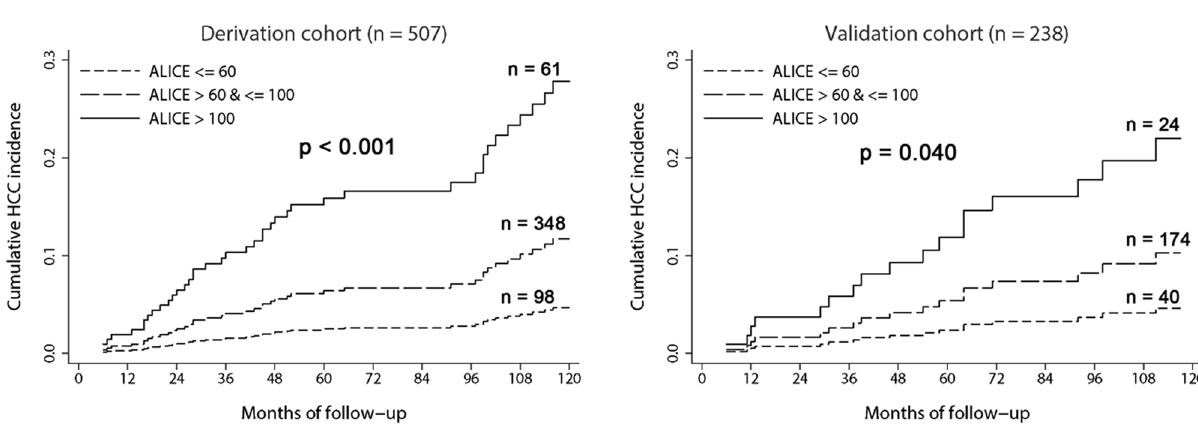
Figure 2. A nomogram for the alcohol-associated liver cancer estimation (ALICE) score.